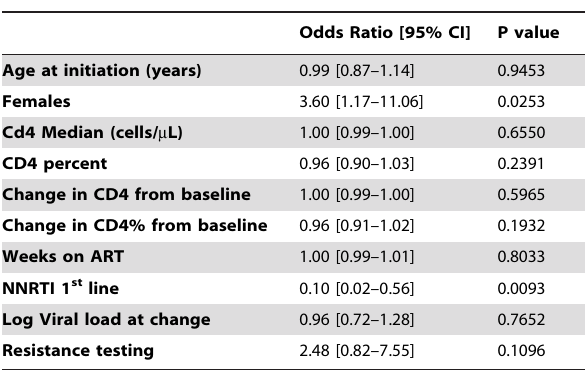
Table 2. Univariate Analysis: Predictors of Six Month Viral Suppression After Change to Second-Line ART in a Cohort of HIV-Infected Children Failing 1 st Line ART in Durban, South Africa.